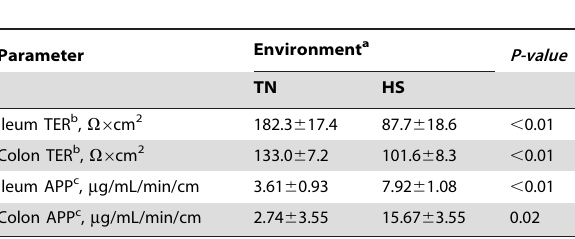
Table 1. Ileum and colon intestinal integrity is compromised in pigs reared in heat stress (HS) conditions compared to thermal neutral (TN).